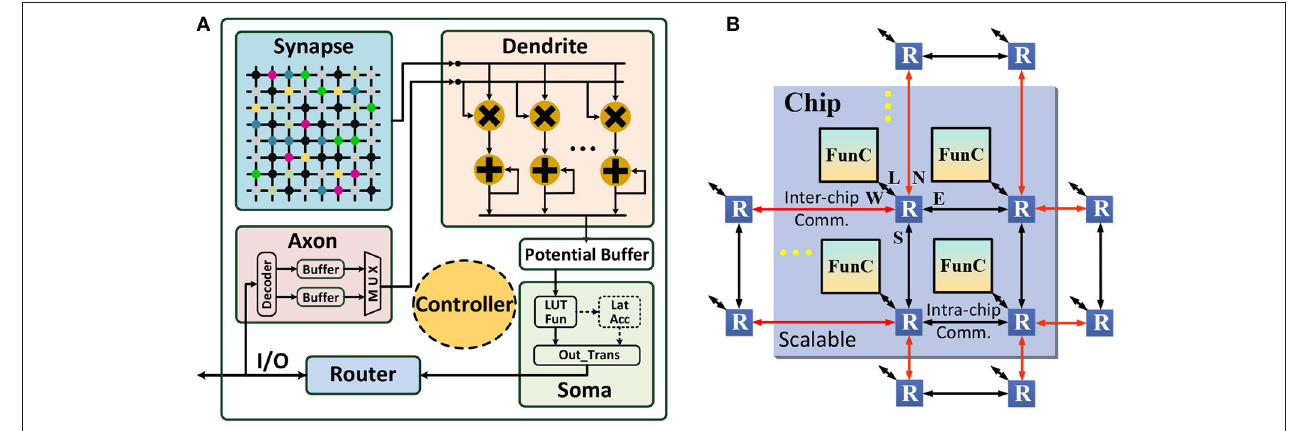
FIGURE 3 | Many-core neural network architecture: (A) functional core (FunC); (B) scalable many-core